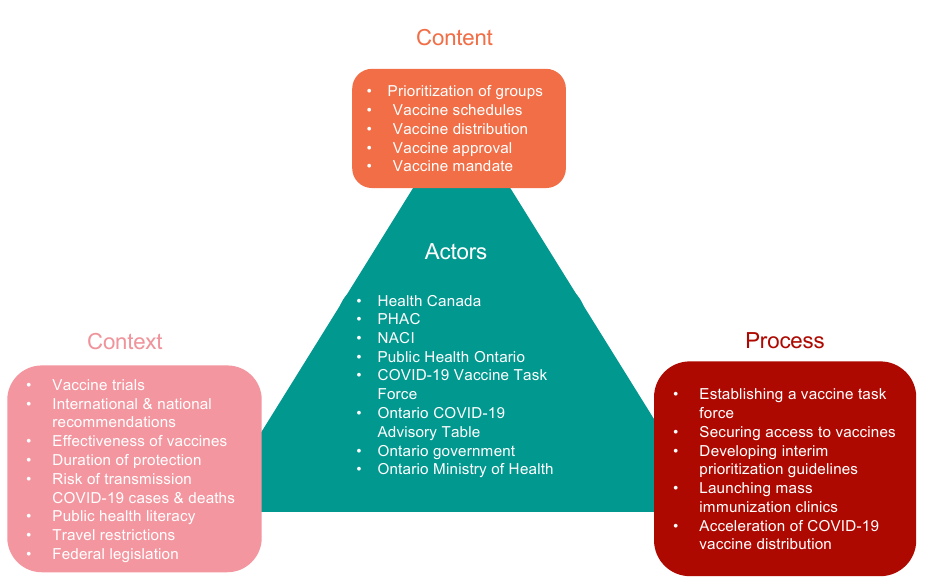
Figure 1. Policy Triangle Framework describing the content, process, context, and actors of the COVID-19 vaccination policies in Ontario, Canada. Table 1. Roles of actors in the Canada pandemic response. Role in Communicating the COVID-19 Actor